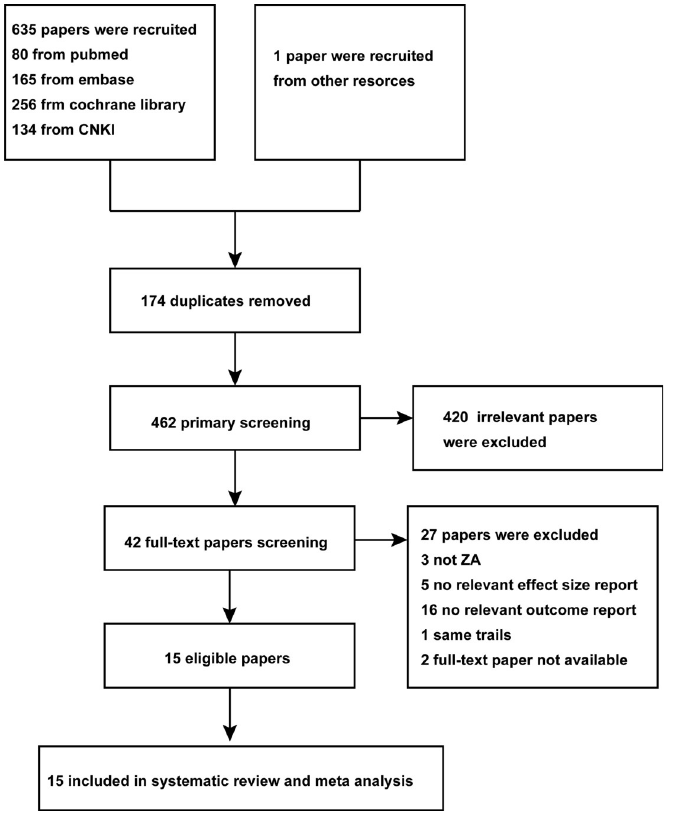
Fig 1. Flow chart to screen eligible